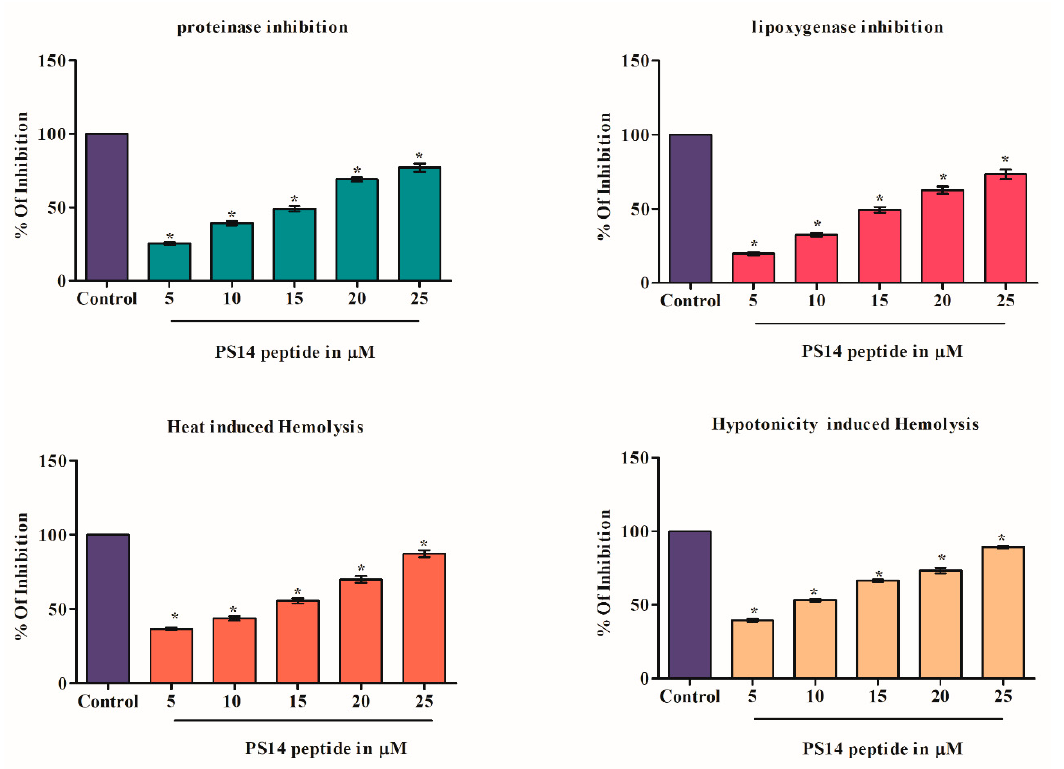
Figure 8. Anti-inflammatory activity of PS14. The results were compared with the untreated control. The data were presented as mean ± SD of three replicates. The asterix (*) represents the significant difference at p < 0.05 compared to the control.